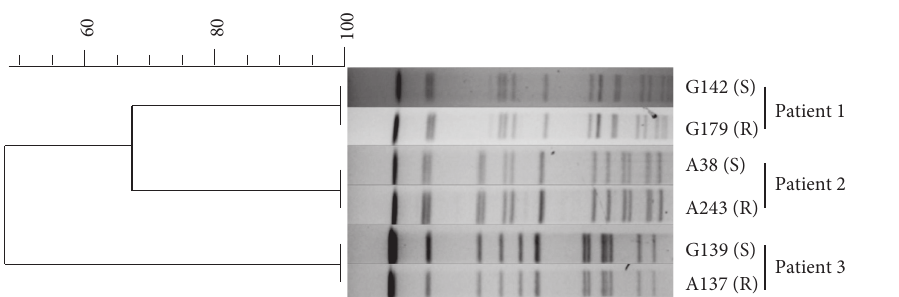
Figure 2: Pulsed-field gel electrophoresis (PFGE) analysis of the phylogenetic distance of M. abscessus isolated from the same patient. The dendrogram was constructed using BioNumerics software Version 6.6 (Applied Maths, St-Martens-Latem, Belgium). S represents sus- ceptible to clarithromycin; R represents resistant to clarithromycin.